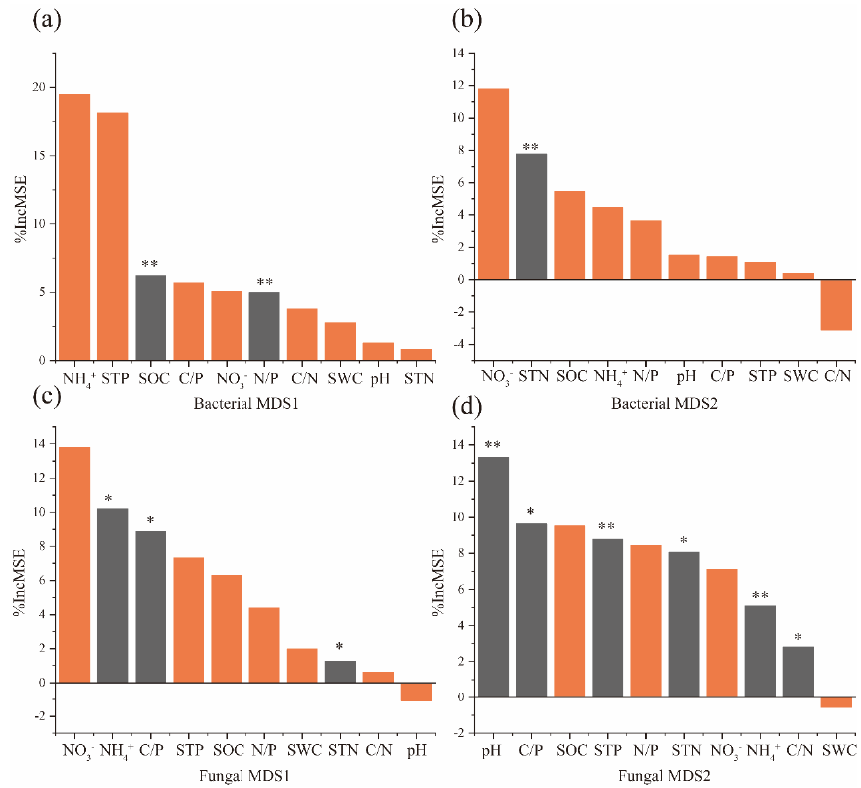
Figure 4. Environmental predictors of the NMDS1 and NMDS2 of bacteria ( a , b ) and fungi ( c , d ) based on random forest analysis. Only predictors with significant effects are shown in the figures. Abbreviations: NO 3 − , nitrate nitrogen; NH 4+ , ammonium nitrogen; STN, total nitrogen; SOC, soil organic carbon; STP, total phosphorus; SWC, soil water content. * p < 0.05 and ** p < 0.01.